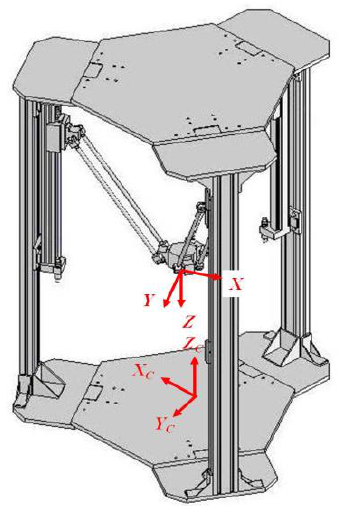
Figure 15. The camera frame and the end-effector frame.